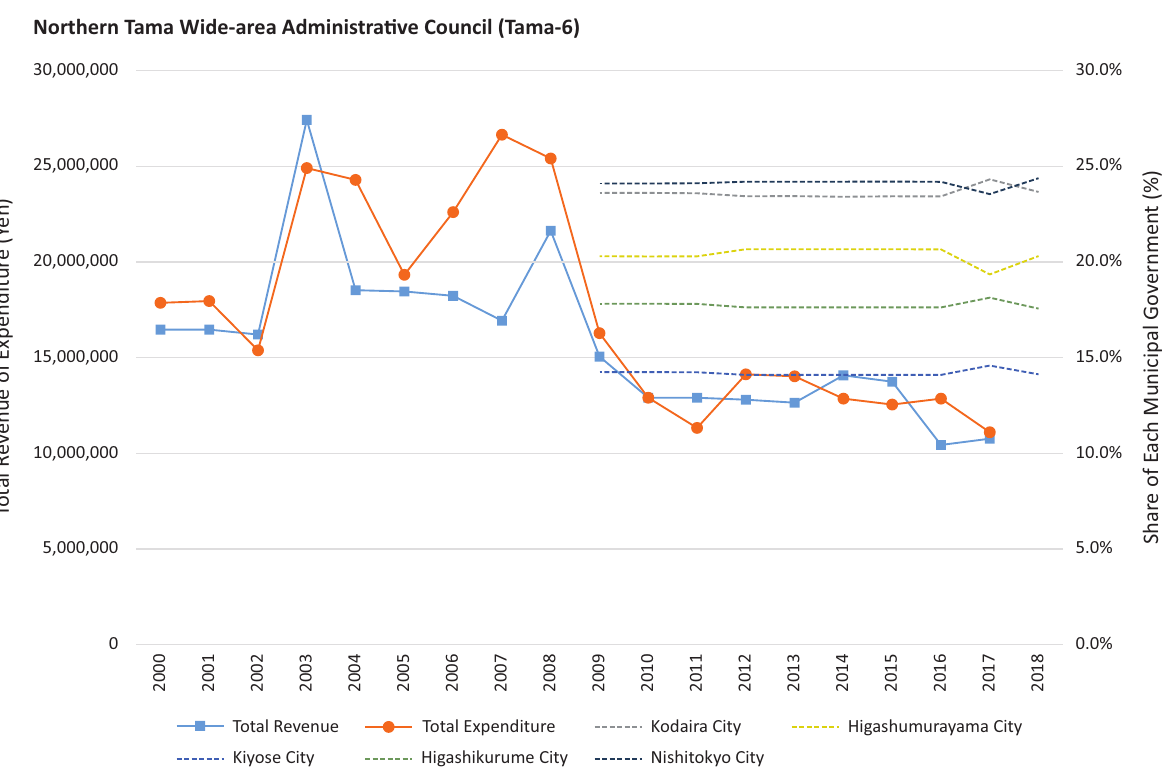
Figure 5. Changes in revenues and expenditures ofthe Western and Northern Tama WACs. Note: The shares of each munic‐ ipal government for the Northern Tama WAC from 2000 to 2008 are unavailable. Sources: Authors’ own, prepared with the use of data obtained directly from these two